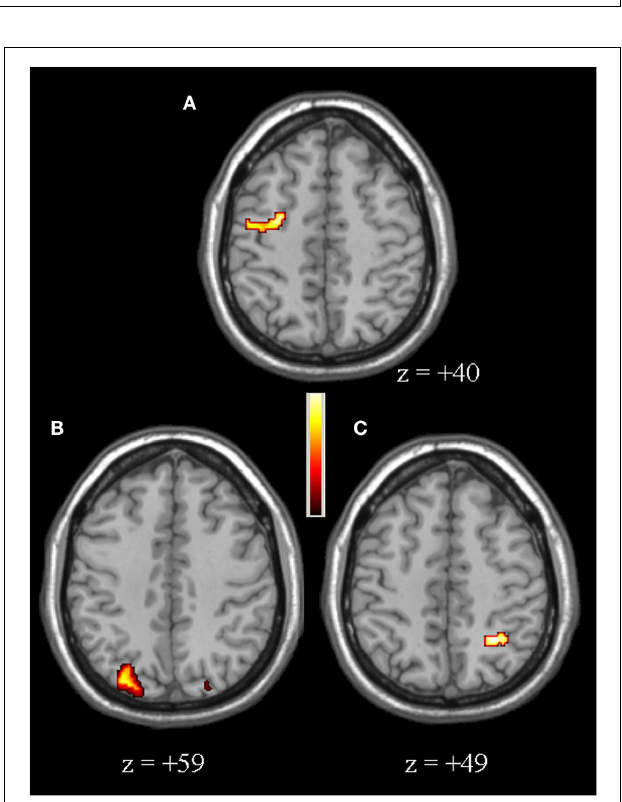
FIGURE 1 |Visuoperceptual and visuospatial tasks. (A) An example of a figure sequence presented in the visuoperceptual task. Subjects were asked to press the key when the target image indicated by the arrow appeared. (B) An example of a figure